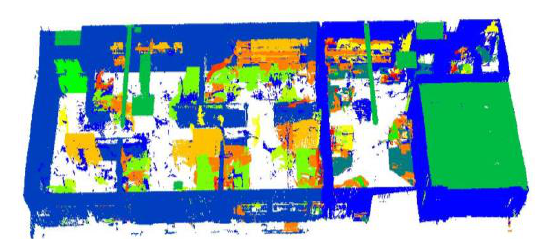
Figure 4. The real dataset is generated by a mobile laser scanner. The left hand side partition of the environment is set as the training site, where the right-hand side partition has both similar computer laboratory office characteristics, meanwhile a fairly different meeting room space is also present to test our algorithm (green part on the lower right).